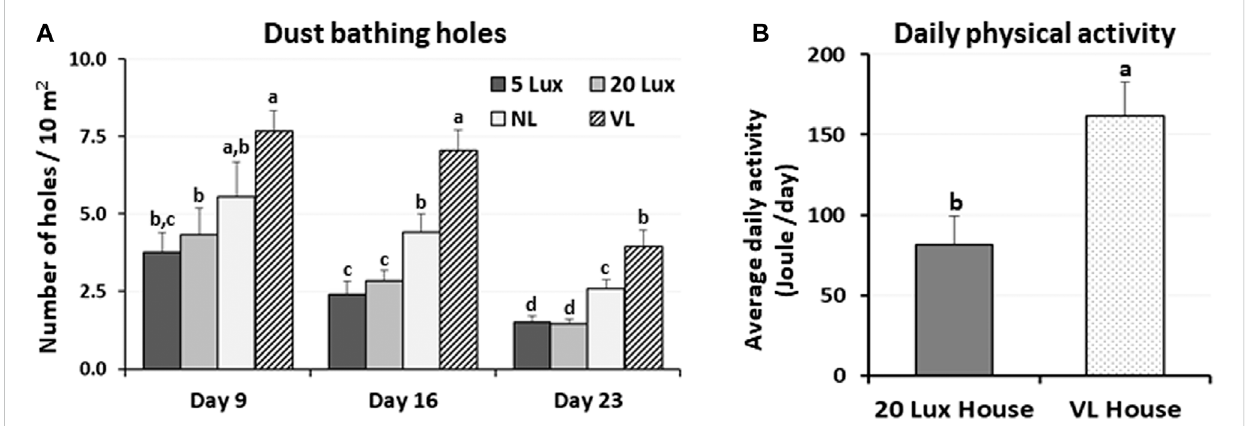
FIGURE 1 Effects of the four differentlighting programs (5 lx, 20 lx, NL, and VL) on the number of dustbathing holesand daily physical activityat differentages. (A) In the each section of trial 3, dustbathing holes as the evidence of dustbathing behavior were counted at 9, 16, and 23 days of age. Dustbathing holes were observed in six parts of each section and number of holes per 10 m 2 was determined. Data (mean ± SEM) were compared among treatments. Differentlower-caselettersabovethebarsdenotesigni fi cantdifferences( p < 0.05)amonggroups,wherea > banda,bisnotdifferentfromaorb. (B) In trial 4, an activity tracker, Animo, was installed on bird using harness at 38 days of age, and uninstalled at 43 days of age (total n = 16, 4/sections, 20 lx and VL house). Average daily activities (calorie consumption) for each bird from day 39 to day 42 obtained. Data (mean ± SEM) were compared between 20 lx and VL houses. Different lower-case letters above the bars denote signi fi cant differences ( p < 0.05) between groups.